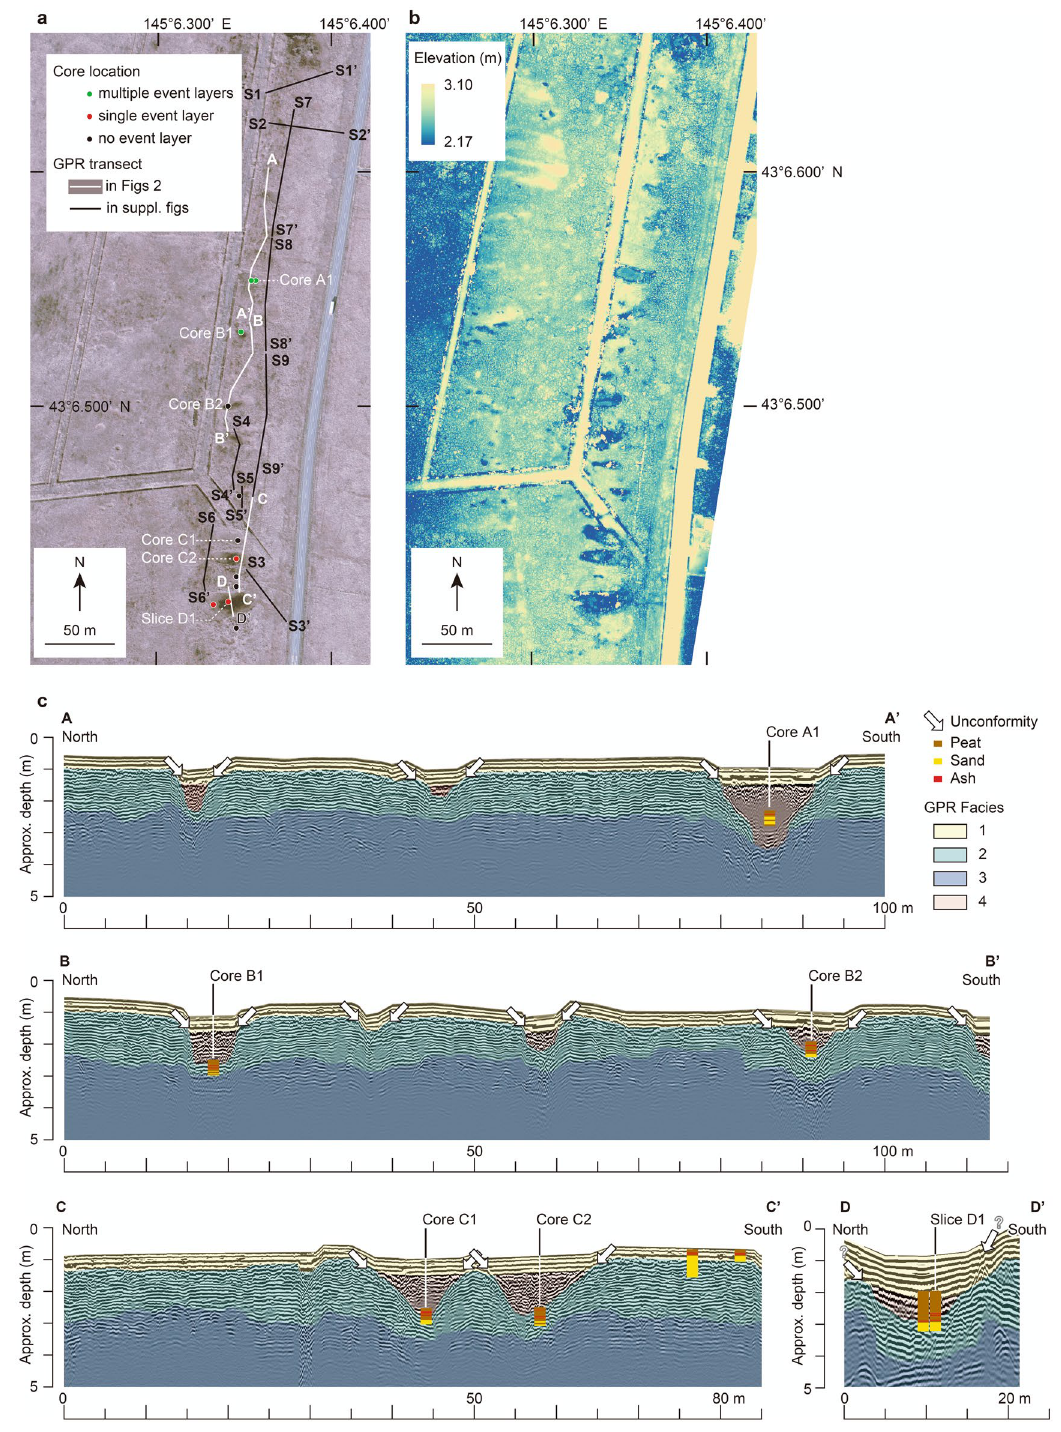
Figure 2. Details of the study site and GPR transects. ( a ) Aerial photograph (CHO-78–07-06B-0012, taken by Geospatial Information Authority of Japan) of the area outlined in Fig. 1b showing core locations and GPR transects. ( b ) DSM obtained in this study, with elevation range restricted to display surface features of the beach ridge. ( c ) Annotated GPR images along the transects shown in ( a ). The four GPR facies identified in this study are differentiated by color. Vertical exaggeration is approximately 4 × . The original GPR images are displayed in Supplementary Fig.